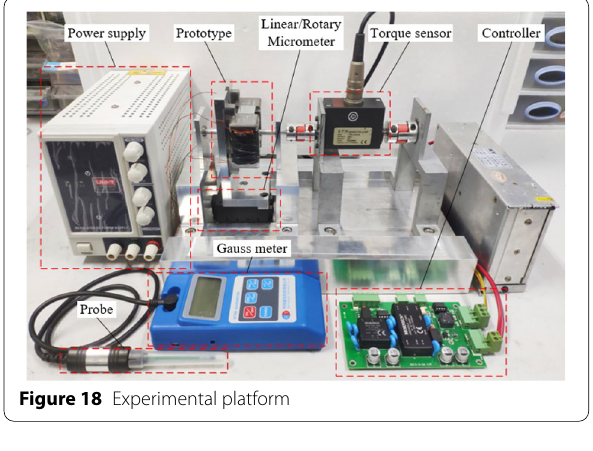
Figure 18 Experimental platform